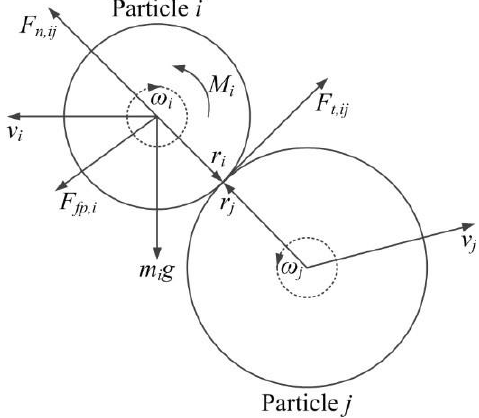
Figure 4. Force analysis of particle collisions.